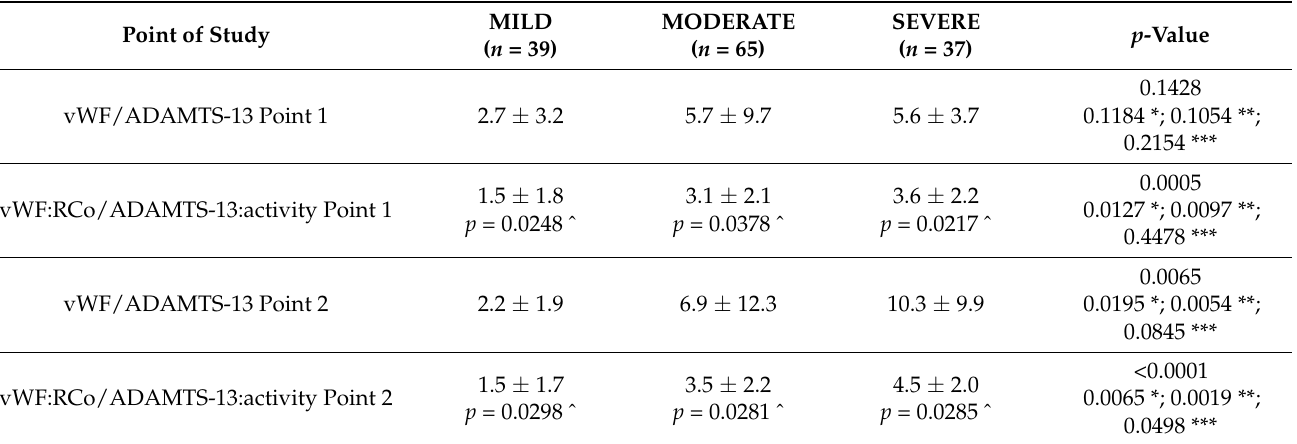
Table 4. vWF/ADAMTS-13 ratio in patients with